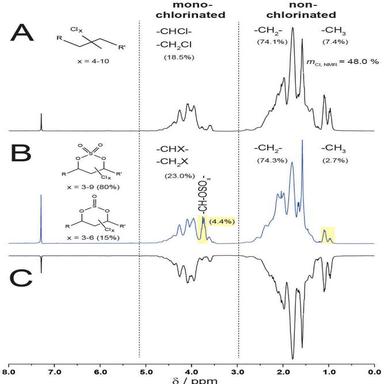
1 H-NMR spectra of a synthesized single-chain C18-CP-material and of side-products. The spectrum of the purified medium-chlorinated CP-material (A, C, black) is compared with the one of F50, containing CP-sulfate- (80%) and -sulfite (15%) diesters (B, blue). Ranges of 1 H-chemical shifts (ppm) of non- and mono-chlorinated hydrocarbons are indicated (dashed lines). The CP-material (A, C) contains mainly chlorinated paraffins (C18H38-xClx, x = 4–10) and some olefinic material. F50 contains mainly CP-sulfate d